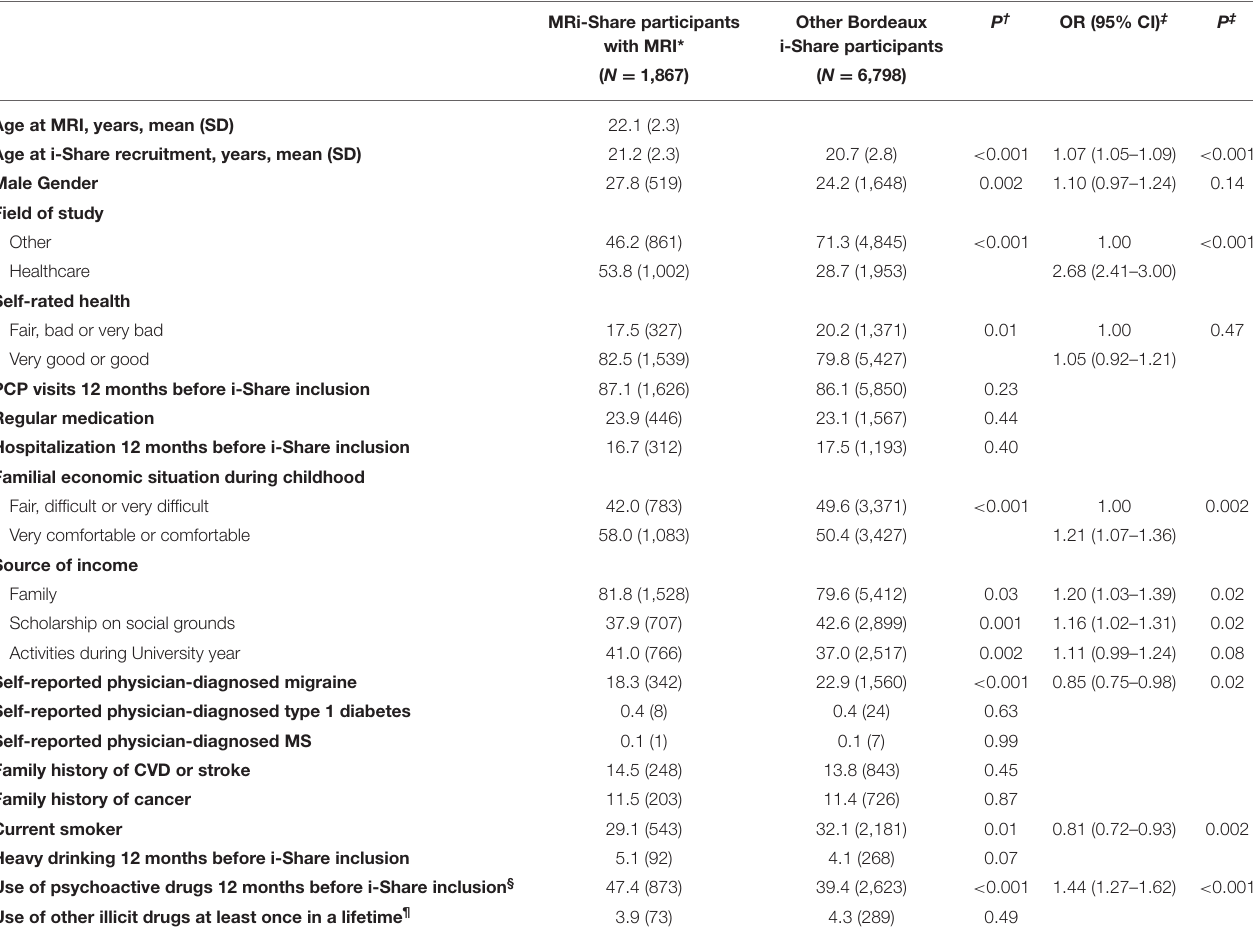
TABLE 1 | Comparison of MRi-Share participants with other participants of i-Share Bordeaux.